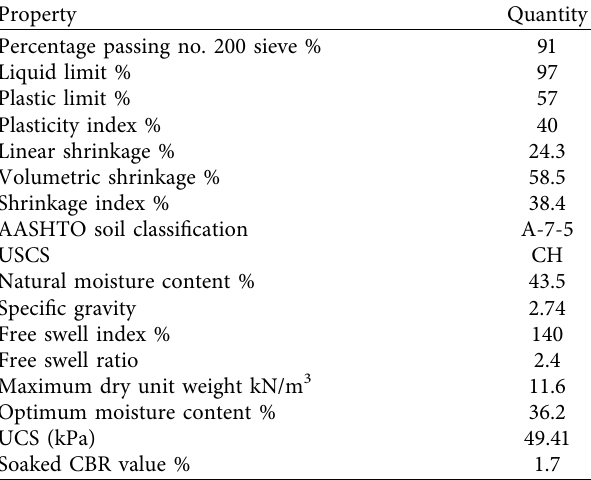
Table 1: Geotechnical properties of expansive soil.